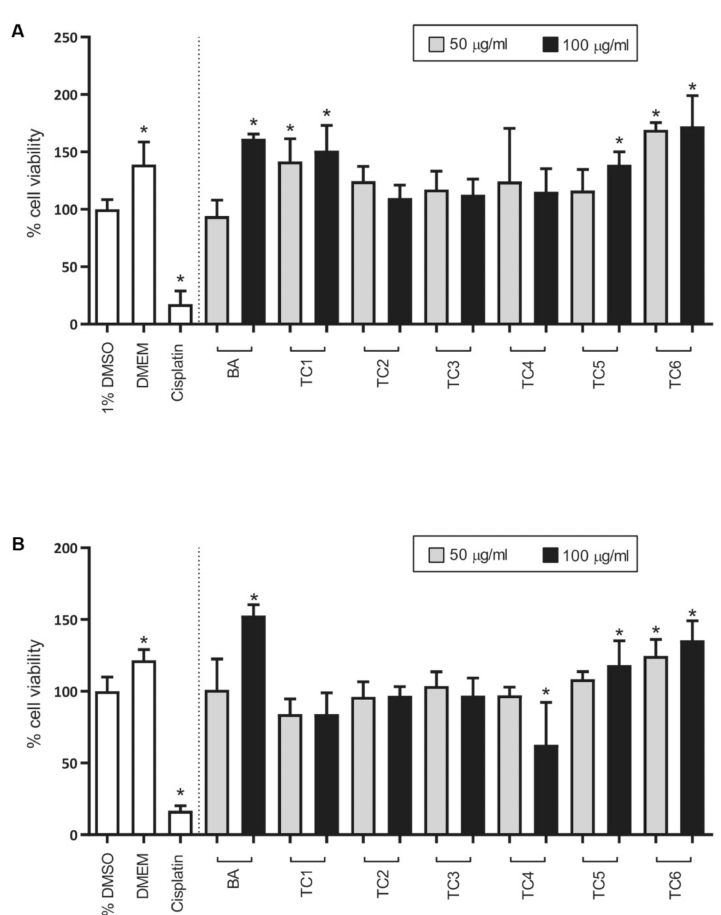
Figure 4. E ff ect of two concentrations (50 and 100 µ g / mL) of MeOH extracts (TC1: root, TC2: leaf, TC3: stem, TC4: loofah, TC5: cell suspension and TC6: callus) and bryonolic acid (BA) compared with 1% v / v DMSO in the ( A ) MCF-7 and ( B ) Saos-2 cell lines. DMEM and cisplatin were used as negative and positive controls, respectively. The bar graph and error bars represent the mean and standard deviation from the experiments, respectively. The asterisk indicates significance (* p -value < 0.05 compared with the 1% v / v DMSO group).